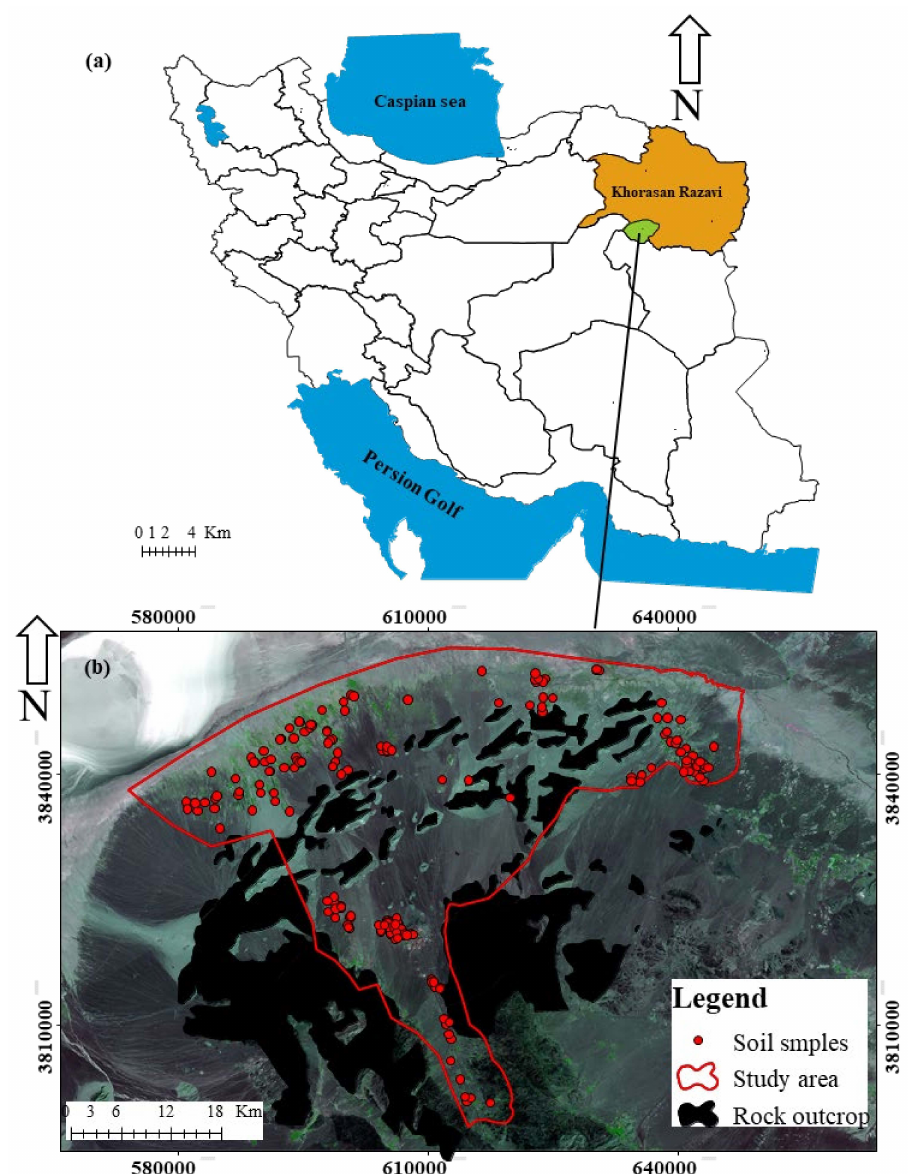
Figure 1. ( a ) The location of the Bajestan area (green area) in Khorasan Razavi province, Iran; ( b ) the spatial distribution of soil samples in cultivated lands draped over the Sentinel-2 image in the study area. Pistachio and barley cultivated lands are located in the northern part of the study area, pomegranate and saffron cultivated lands in the center and southern